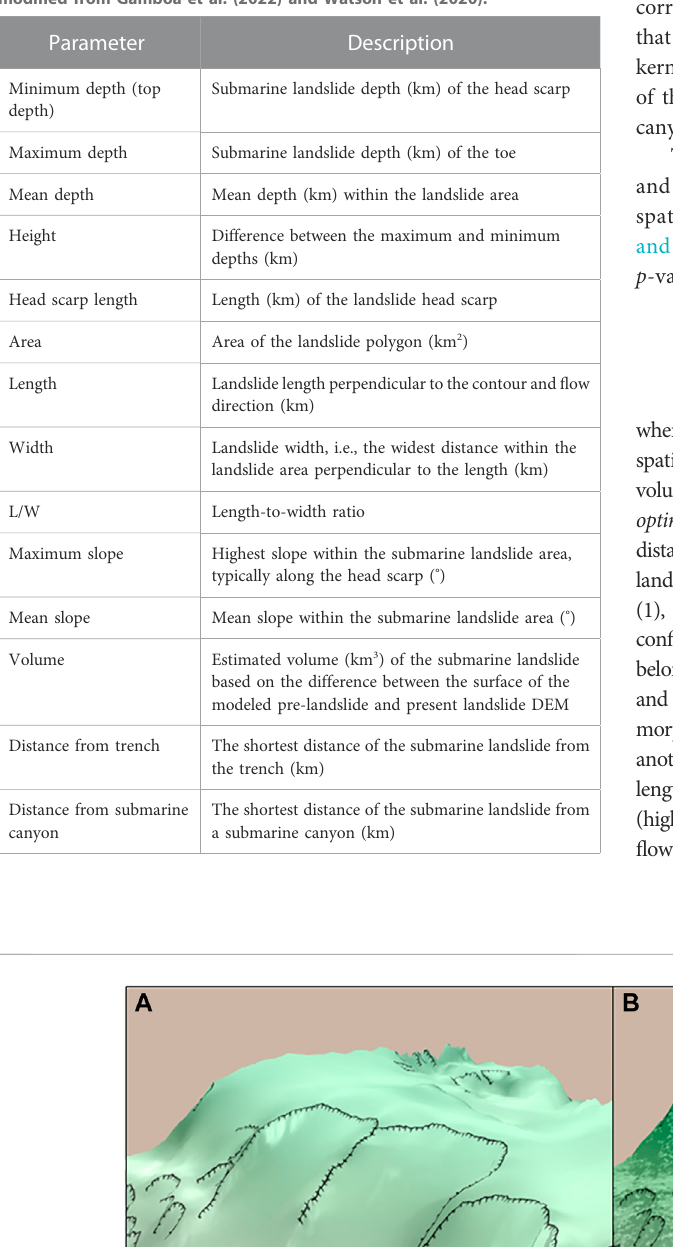
TABLE 1 Delineated morphometric parameters of submarine landslides modi fi ed from Gamboa et al. (2022) and Watson et al. (2020).